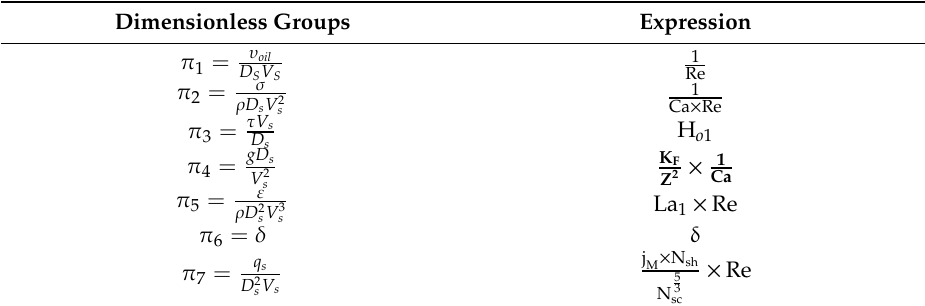
Table 5. The dimensionless groups in Equation